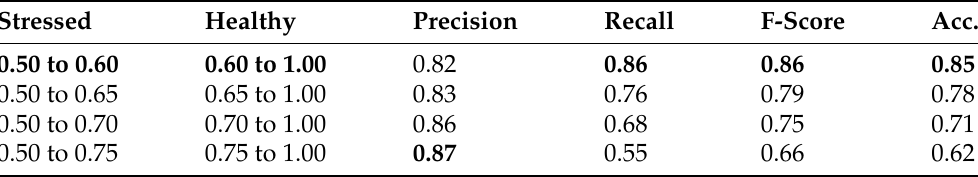
Table 10. Accuracy assessment using different threshold ranges at Level-3b classification for stressed and healthy regions. Note that each row represents the averaged metrics (Precision, Recall, F-score, and Accuracy) of four LGAs under Level-3b classification. The boldface represents the optimal threshold range and resulting best